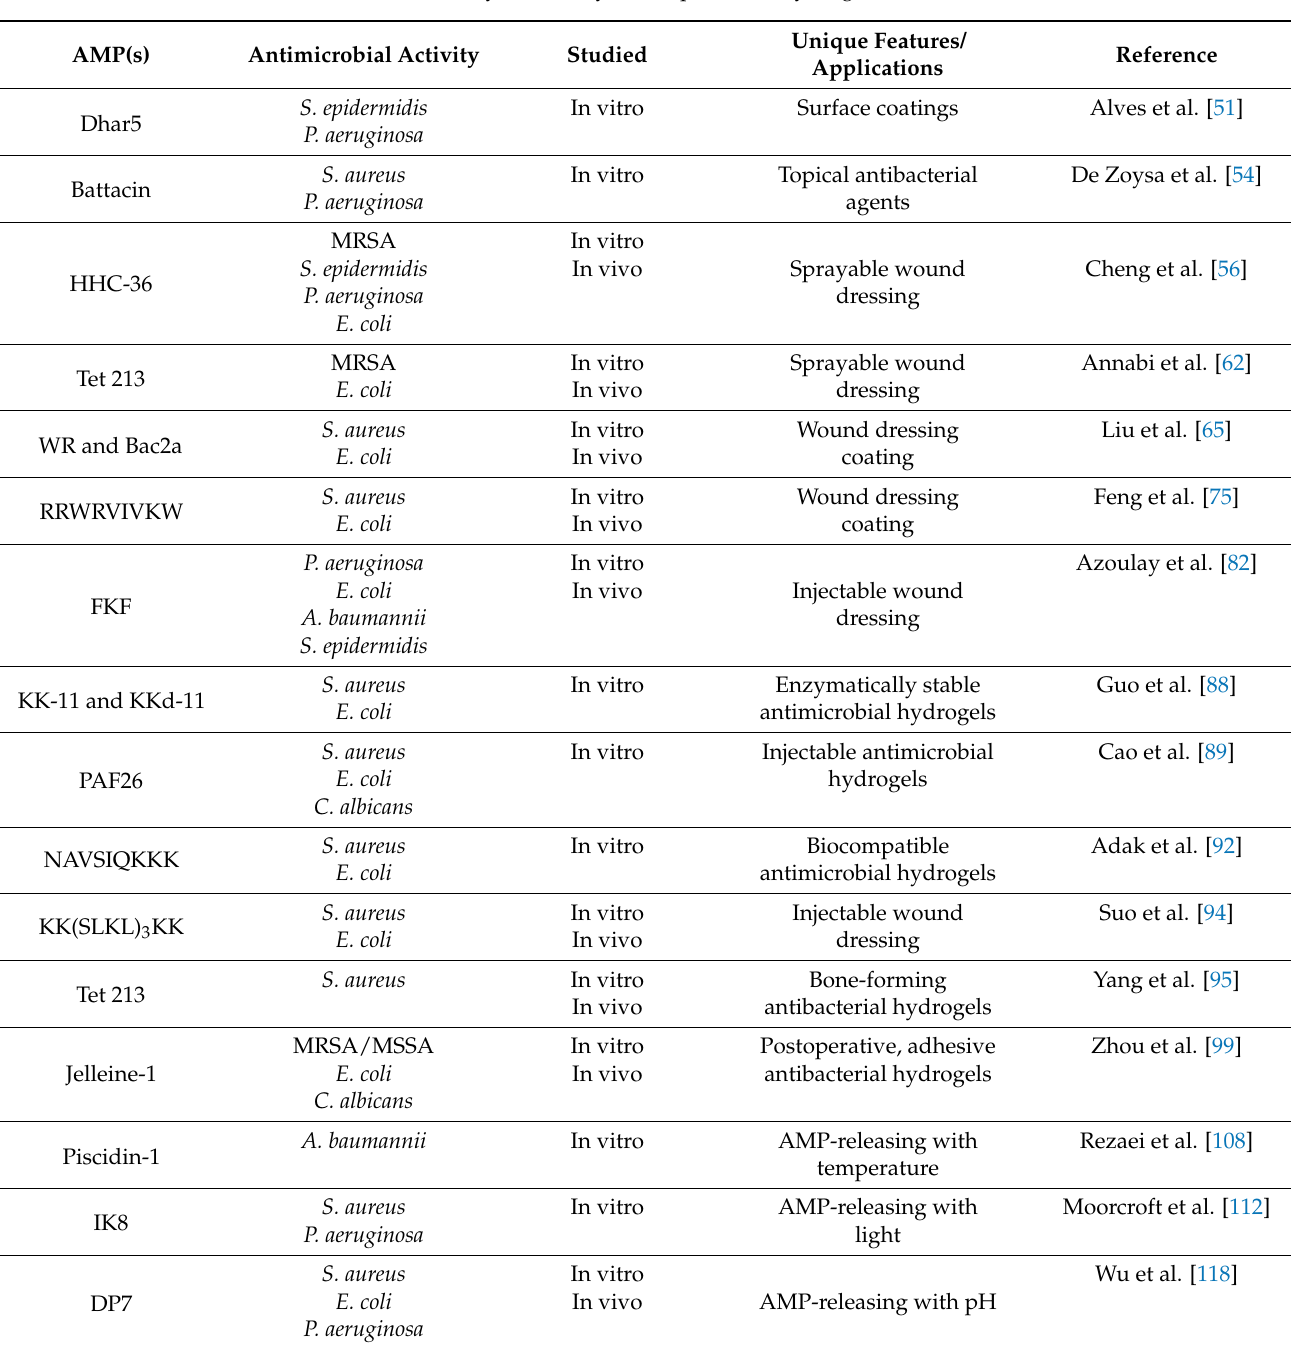
Table 1. Summary of recently developed AMP